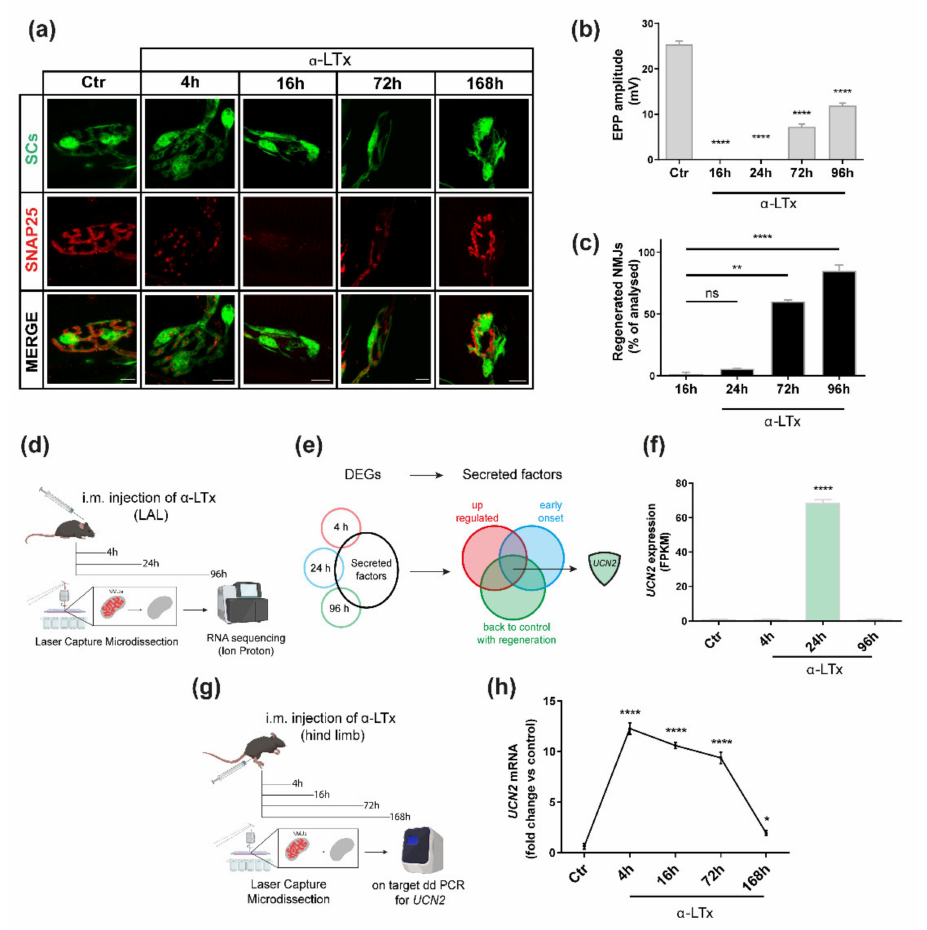
Figure 1. Time course of NMJ degeneration and regeneration by α -LTx reveals a strong upregulation of the UCN2 gene. ( a ) Time course of MAT degeneration and regeneration induced by α -LTx in soleus muscles assessed by immunostaining at 4, 16, 72, 168 h after intoxication. SCs (green) are GFP-positive, SNAP25 (red) identifies the presynaptic nerve terminals. Scale bars = 10 µ m. ( b ) Time course of loss and progressive recovery of motor axon activity by evoked EPP recordings in soleus muscles at the indicated time points. Histograms show the average amplitude of evoked EPPs ± SD. n = 4 animals, 11 fibres each. **** p < 0.0001. ANOVA followed by post hoc Tukey test. ( c ) Quantification of regenerated NMJs in soleus muscles at the indicated time points after α -LTx injection. Regenerated NMJs display both pre- and post-synaptic markers (VAMP-1 and nAChR stained with α -BTx, respectively). Each bar represents the mean ± SD percentage of recovered NMJs compared to non-treated animals. **** p < 0.0001, ** p < 0.01 by ANOVA followed by post hoc Tukey test. ( d ) Experimental pipeline of NMJ transcriptome profiling throughout the process of degeneration and regeneration caused by α -LTx. Mice were injected with the toxin close to LAL muscle, which was then isolated and snap-frozen at the indicated time points. Single NMJs were isolated by LCM from cryo-sliced muscles. At least 150 NMJs were pooled and their RNA extracted, amplified and sequenced with the Ion Torrent technology. ( e ) Scheme depicting the workflow and criteria used to process the NMJ dataset. ( f ) Graph showing UCN2 mRNA profile, expressed as FPKM (fragments per kilobase of exon per million fragments mapped) during MAT degeneration and regeneration induced by α -LTx in LAL muscles. Data are presented as mean ± SD. **** p < 0.0001 (ctr vs. 24 h) from 3 independent replicates. ( g ) Experimental workflow to assess UCN2 mRNA levels in soleus muscles 4, 16, 72, 168 h after local injection of α -LTx. Time points were chosen on the basis of the time course of MAT degeneration and regeneration by α -LTx as described above. ( h ) UCN2 mRNA levels measured via digital PCR on NMJs isolated by LCM from soleus muscles. Data are expressed as fold change compared to control. Each bar represents mean ± SD. n = 4 animals. **** p < 0.0001, * p < 0.05. ANOVA followed by post hoc Tukey